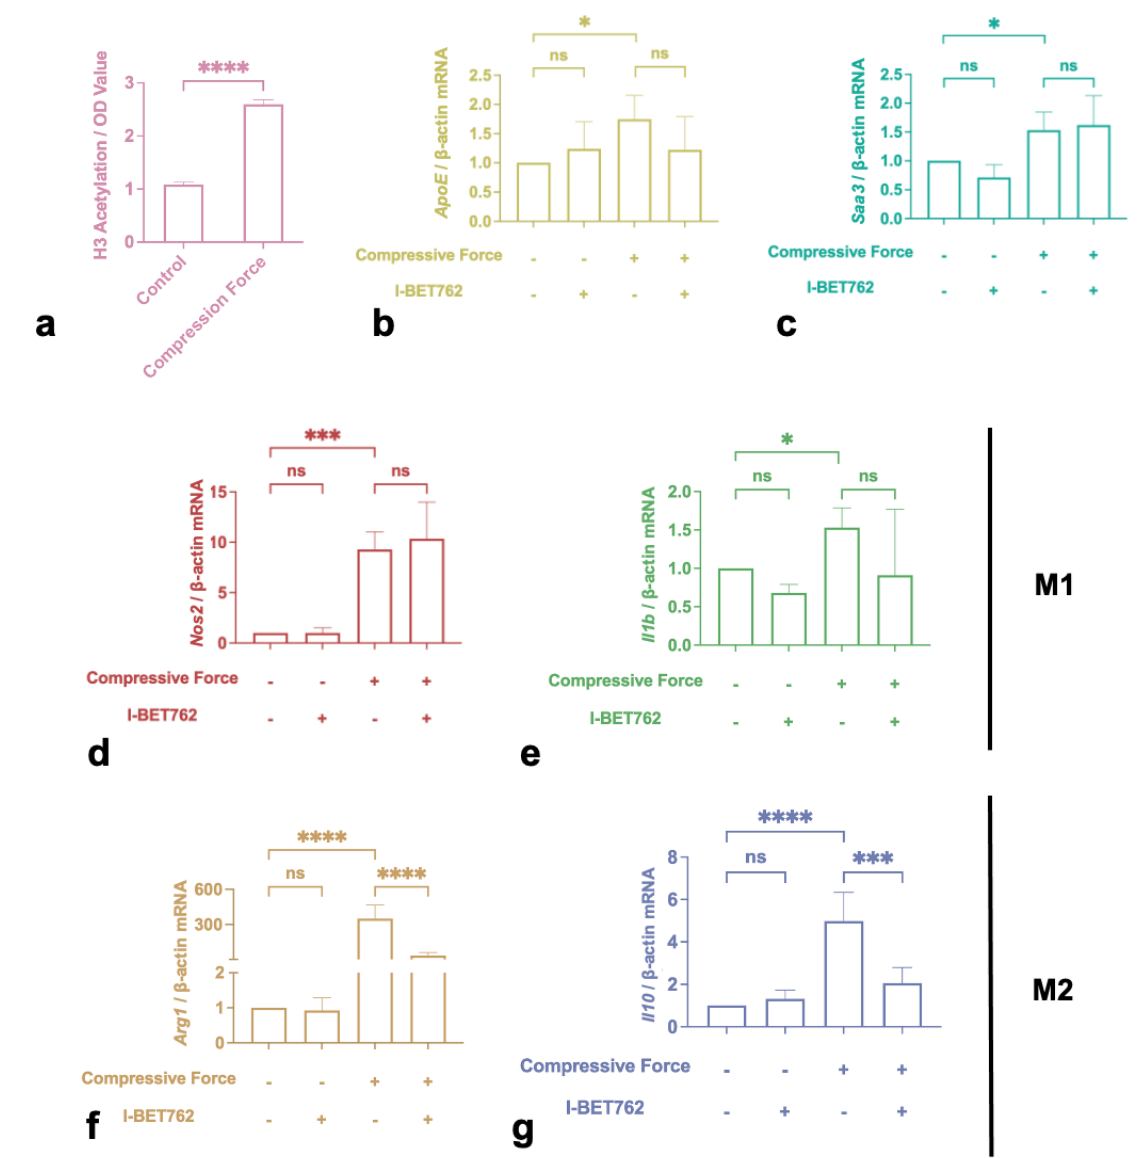
Figure 4. Compressive force induced M2 polarization by promoting H3 histone acetylation. ( a ) H3 histone acetylation level increased after force-loading. ( b – e ) ApoE , Saa3 , Nos2 , and Il1b showed no reaction to I-BET762 in the presence or absence of compression. ( f , g ) I-BET762 blunted the effects of force on Arg1 and Il10 expression. Values are expressed as means ± SD; ns—not significant; * p < 0.05; *** p < 0.001; **** p < 0.0001.